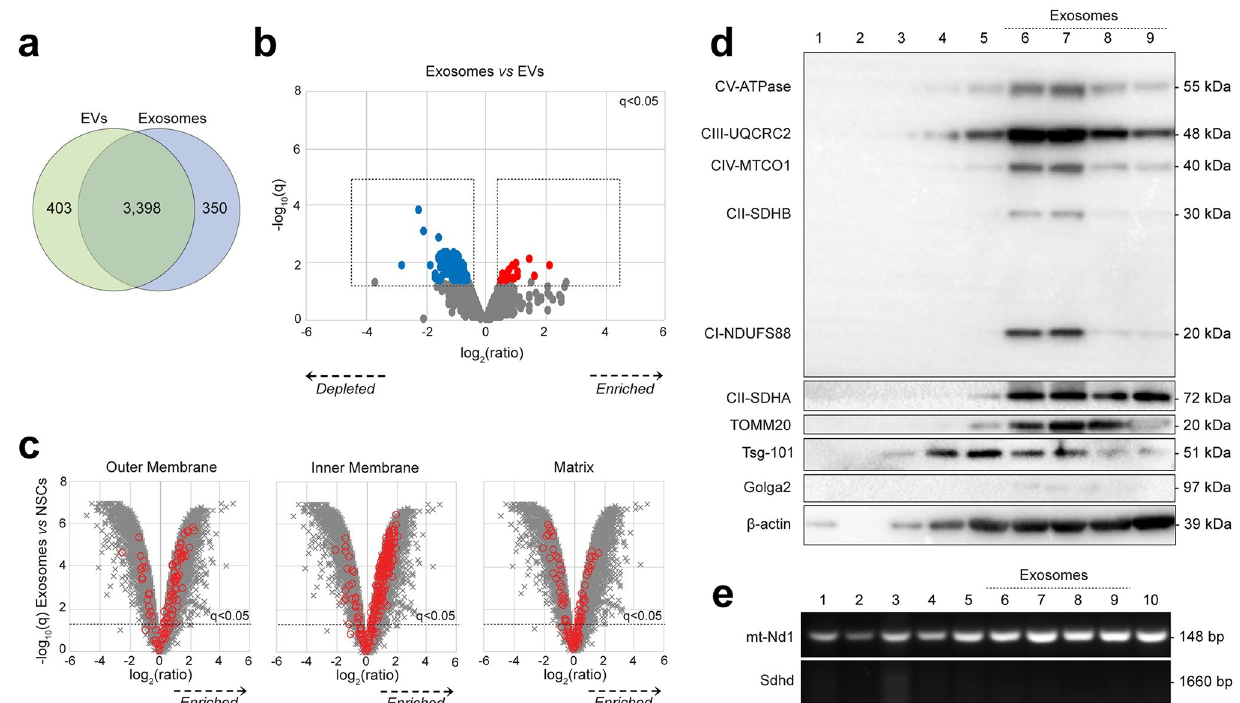
Fig 3. Proteomic analysis of EVs and exosomes. (a) Overview of proteins enriched in EVs and/or exosomes. Venn diagram shows overlap of 4,151/ 9,971 cellular proteins significantly enriched (q < 0.05) in either EVs (green) or exosomes (blue) or both, compared with NSCs. (Data available on ProteomeXchange, identifier PXD024368, and in S3 Data). (b) Relative abundance of proteins in exosomes (fractions 6–9) compared with EVs. Volcano plot shows statistical significance ( y axis) vs. fold change ( x axis) for 9,951/9,971 cellular proteins quantitated across all N = 3 biological replicates (no missing values) in the multiplex TMT-based functional proteomic experiment illustrated in Fig 1A. A total of 187 proteins were found to be significantly depleted in exosomes vs. EVs (blue), while 25 proteins were significantly enriched (red); q < 0.05 (S1 Data). (Data available on ProteomeXchange, identifier PXD024368, and in S3 Data). (c) Relative abundance of proteins from different mitochondrial compartments (outer membrane, matrix, and inner membrane) in exosomes (fractions 6–9) compared with NSCs. Volcano plots show statistical significance ( y axis) vs. fold change ( x axis) for 9,951/ 9,971 cellular proteins quantitated across all 3 biological replicates (no missing values) in the multiplex TMT-based functional proteomic experiment illustrated in Fig 1A. Proteins annotated with the following GOCC subcellular localisations are highlighted in red: mitochondrial outer membrane (GO:0005741, enriched in EVs); mitochondrial matrix (GO:0005759, enriched in EVs); and mitochondrial inner membrane (GO: 0005743, enriched in EVs). An FDR threshold of 5% is indicated (proteins with Benjamini–Hochberg FDR-adjusted p -values (q values) < 0.05). (d) Representative protein expression analysis by WB of EV fractions (2–10) obtained via continuous sucrose gradient. Fractions 6–9 (corresponding to the expected exosomal density between 1.13 and 1.21 g/ml) were specifically enriched for mitochondrial complex proteins (CV-ATPase, CII-SDHA, CI-NDUFS88, CII-SDHB, CIV-MTCO1, and CIII-UQCRC2), for the mitochondrial outer membrane translocase TOMM20, and the exosomal marker Tsg-101 (while they were negative for the Golgi marker Golga2). β -actin is also shown. (e) Representative PCR amplification of DNA extracted from EV fractions (2–10) obtained via continuous sucrose gradient. The mitochondrial encoded gene mt-ND1 was found to be present in most of the EV fractions, while the nuclear encoded mitochondrial gene Sdhd was used as negative control. EV, extracellular vesicle; FDR, false discovery rate; mt-ND1 , mitochondrial gene NADH dehydrogenase subunit 1; PCR, polymerase chain reaction; Sdhd , succinate dehydrogenase complex subunit D; TMT, Tandem Mass Tag; WB, western